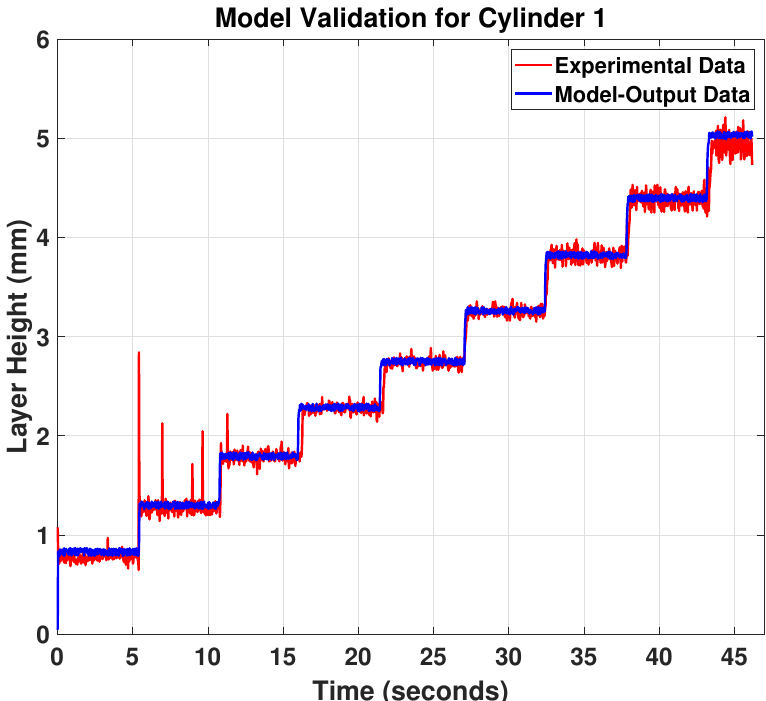
Figure 9. Model validation for cylinder 1.